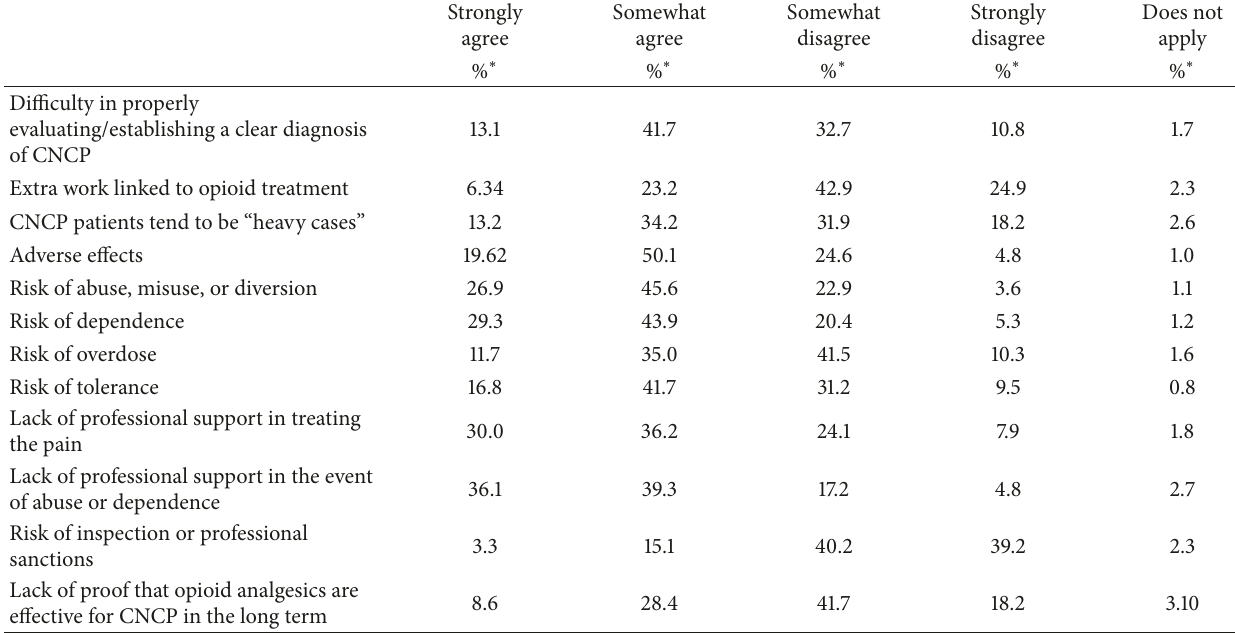
Table 4: Barriers to opioid analgesic prescription ( 𝑁 = 636